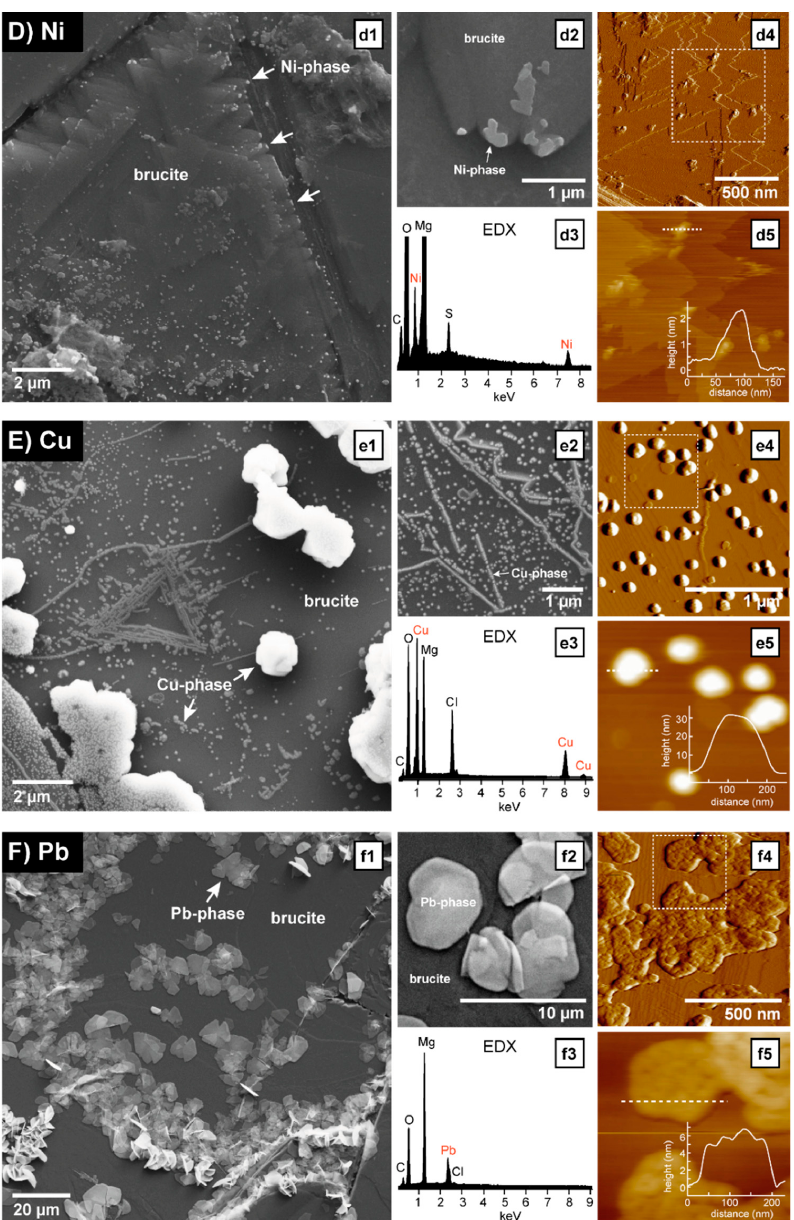
Figure 4. Chemical and morphological characterization of surface precipitates formed during reactions with solutions of ( A ) ZnSO 4 , ( B ) CdSO 4 , ( C ) CoSO 4 , ( D ) NiSO 4 , ( E ) CuCl 2 , and ( F ) PbCl 2 . ( a1 – f1 ) SEM images showing the coverage of brucite surfaces with precipitates. All of the SEM images are from brucite surfaces that reacted for 36 h with 7 mL of the respective metal solution at pH 4.5. Concentrations were 10 mmol/L for Zn, Cd, Co, Ni, and Cu ( a1 – e1 ), and 1 mmol/L for Pb ( f1 ). The brucite surfaces were initially clean and free of any precipitates. ( a2 – f2 ) Higher magnification SEM images of surface precipitates from the same samples as in a1–f1. ( a3 – f3 ) Energy dispersive X-ray (EDX) spectra of the surface precipitates showing the incorporation of metals. The high Mg peak that is present in all of the spectra originates from the underlying brucite surface. ( a4 – f4 ) AFM deflection and ( a5 – f5 ) height images of surface precipitates highlighting some similar and additional morphological features. The location of the height images is indicated by a dashed square in the corresponding deflection image. Insets in ( a5 – f5 ) show the height profiles along the sections marked by the dashed lines. The experimental conditions for the AFM images were ( a4 , a5 ) 50 mmol/L ZnSO 4 , pH 5.75, ~2 h in situ (flow) + 16 h ex situ (static), image acquired in air; ( b4 , b5 ) 20 mmol/L CdSO 4 , pH 4.5, 40 min in situ (flow), image acquired in liquid; ( c4 , c5 ) 50 mmol/L CoSO 4 , pH 5, ~2 h in situ (flow) + 95 h ex situ (static), image acquired in air; ( d4 , d5 ) 20 mmol/L NiSO 4 , pH 5, 45 min in situ (flow), image acquired in liquid; ( e4 , e5 ) 20 mmol/L CuCl 2 , pH 4.5, ~2 h in situ (flow) + 20 h ex situ (static), image acquired in air; and ( f4 , f5 ) 1 mmol/L PbCl 2 , pH 4.5, ~2 h in situ (flow) + 20 h ex situ (static), image acquired in